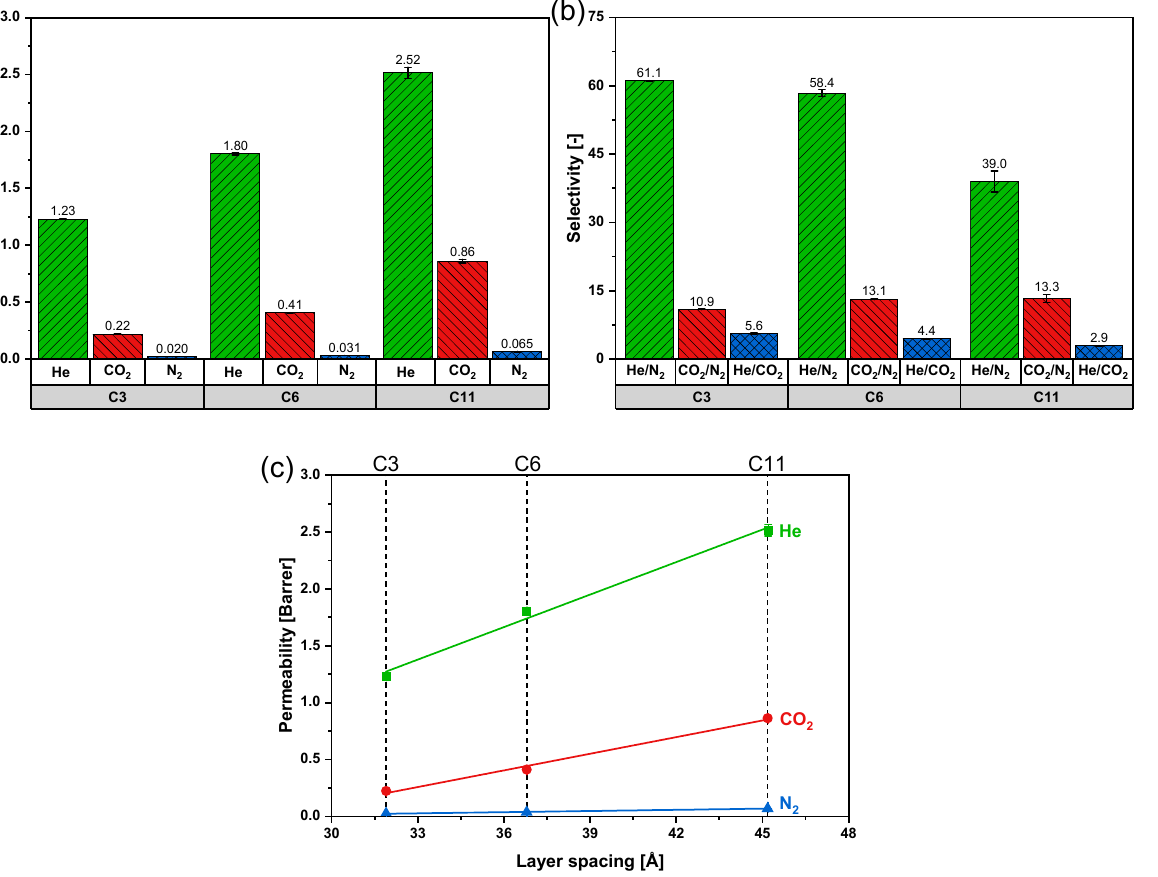
Figure 3. Gas permeation data and ideal gas selectivities of smectic LC membranes with various layer spacings. ( a ) Single gas permeability (He, CO 2 and N 2 ) of C3 , C6 and C11 membranes measured at 40 ◦ C and 6 bar feed pressure. ( b ) Ideal gas selectivities (He/N 2 , CO 2 /N 2 and He/CO 2 ) of C3 , C6 and C11 membranes measured at 40 ◦ C and 6 bar feed pressure. ( c ) Single gas permeability (He, CO 2 and N 2 ) versus the layer spacing of the C3 , C6 and C11 membranes. The small error bars represent the spread of two independently prepared membranes, where each membrane is measured in